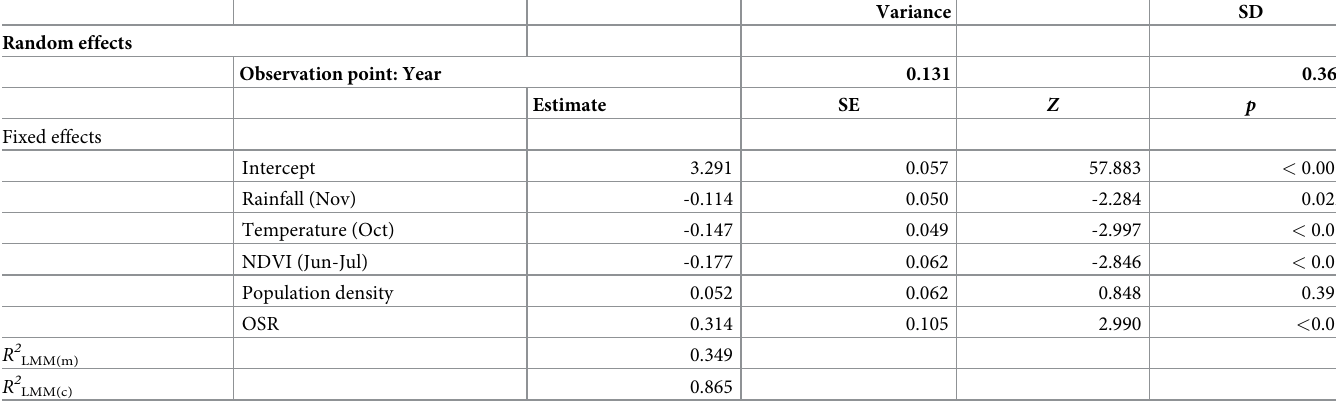
Table 4. Coefficients of the linear mixed-effects model on the opportunity for sexual selection at rut peak. R 2 LMM(m) is the marginal R-squared and R 2 LMM(c) is the conditional